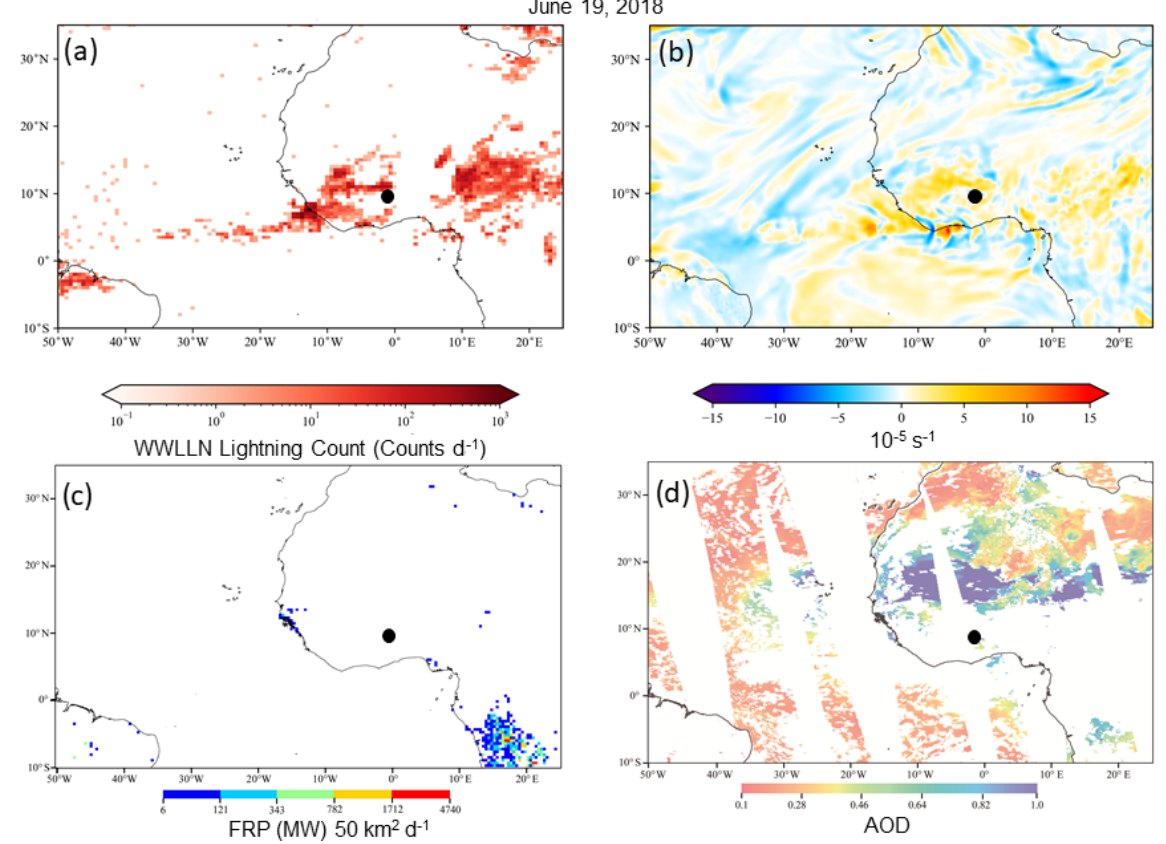
Figure 14. Same as Fig. 13 but for the EIE event recorded on 19 June 2018 (black